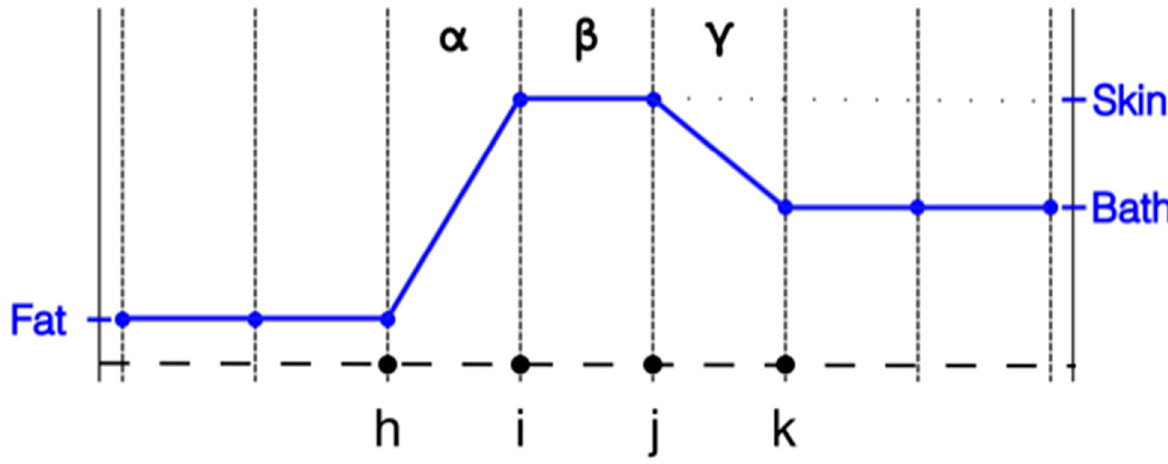
Figure 1. 1D property distribution transecting from fat to skin to coupling bath, respectively.